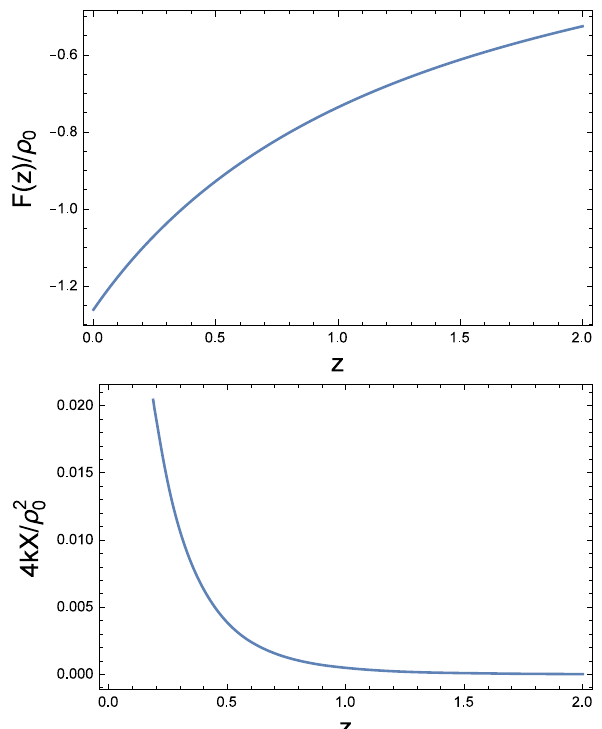
Fig. 7 Here we display F and X as functions of redshift derived in the text for model D